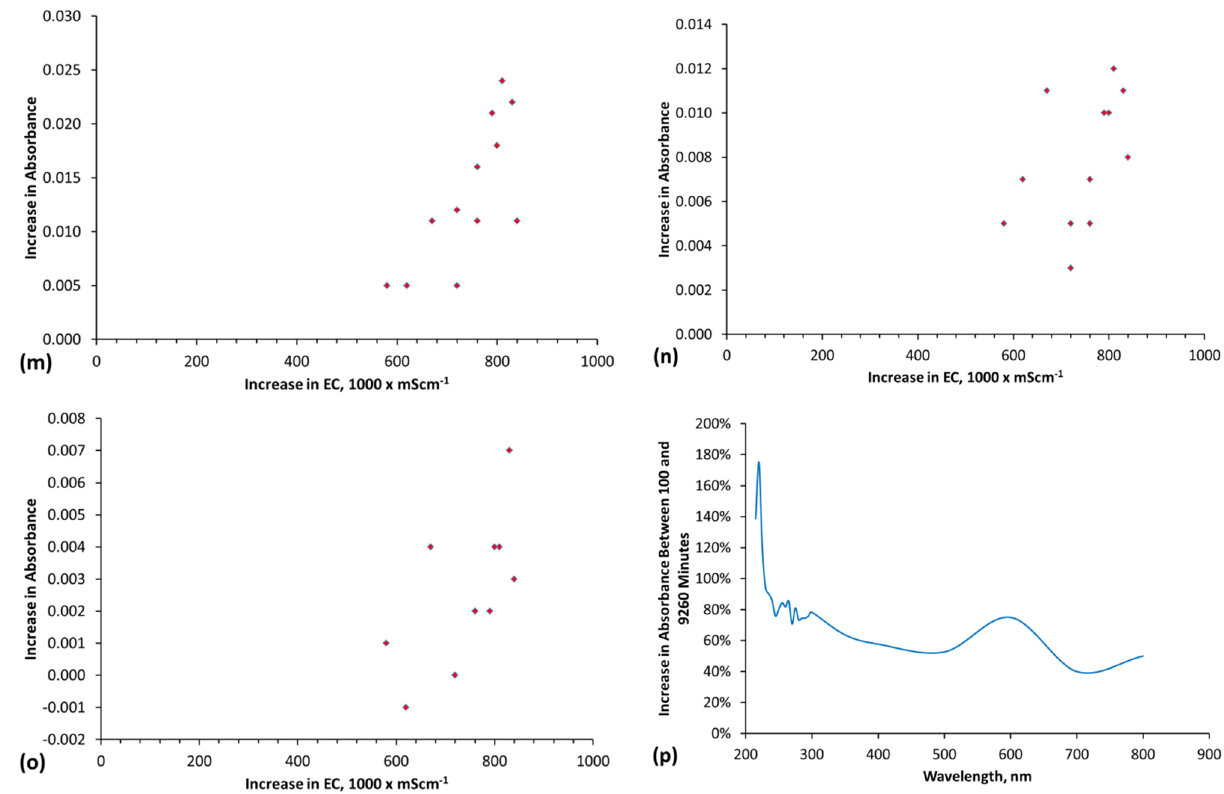
Figure E4. ZVM TPA example. ( a ) EC vs. Time; ( b ) Product water absorbance (relative to fresh water) as a function of time, t . t = minutes; ( c ) Increase in absorbance due to nano-particles as a function of time; Relationship between increase in absorbance at different wavelengths and the increase in EC: ( d ) 215 nm; ( e ) 225 nm; ( f ) 235 nm; ( g ) 245 nm; ( h ) 255 nm; ( i ) 265 nm; ( j ) 275 nm; ( k ) 285 nm. ( l ) 295 nm; ( m ) 350 nm; ( n ) 500 nm; ( o ) 700 nm; ( p ) Increase in absorbance between 100 and 9260 min. Reactor details: batch processing: 0.24 m 3 water volume; initial water salinity = 1.33 g·L − 1 ; Operating Temperature = 15–22 °C (atmospheric); Reactor location: External; ZVM TP cartridge: 0.4 kg: Feed Water: EC = 2.9 mS·cm − 1 ; Eh = 0.181 V; pH = 6.24; T = 16.5 °C; Product Water: EC = 3.69 mS·cm − 1 ; Eh = 0.173 V; pH = 7.65; T = 15